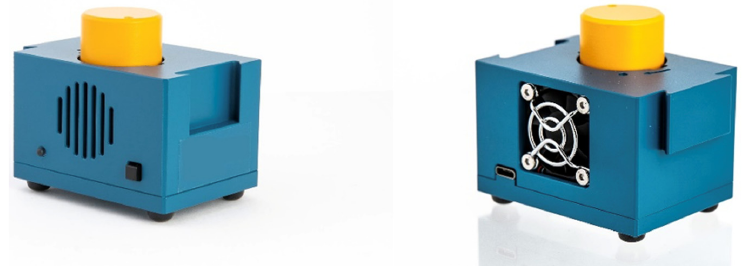
Figure 3. LoopDeelab